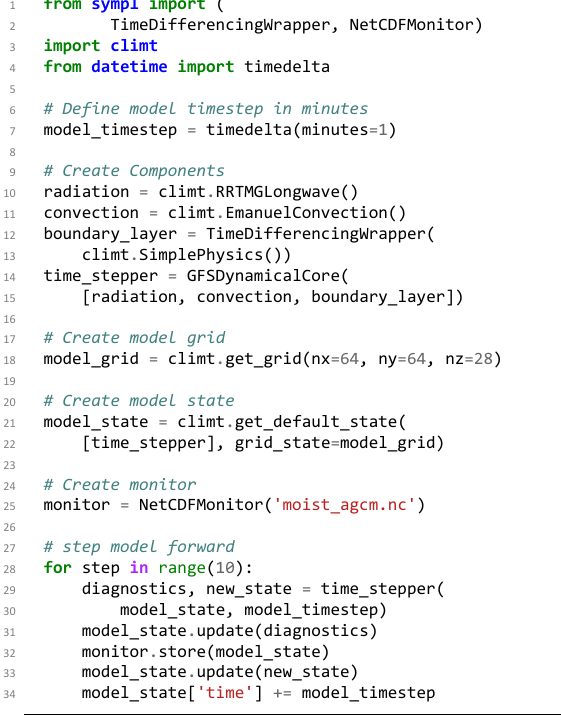
Figure 3. A Python script which creates an idealized moist atmo- spheric general circulation model. See text for a detailed descrip-